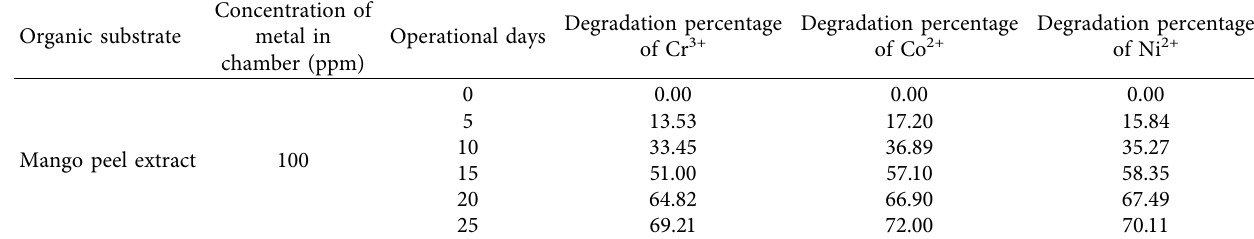
Figure 4: (a) CV at diferent days (b) specifc capacitance values. Table 2: Recorded degradation efciency of metal ions in